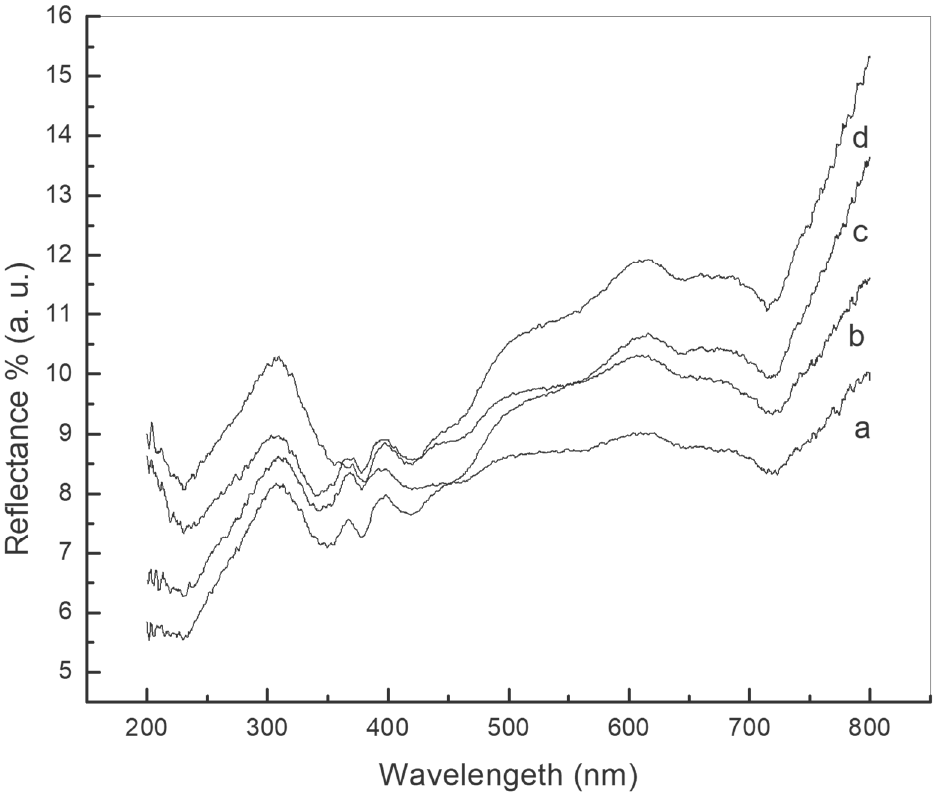
Figure 7. The reflectance of prepared samples at temperatures of (a) 500, (b) 600, (c) 700, and (d) 800 °C. Table 2. Summary of calcination temperatures and bandgaps values.